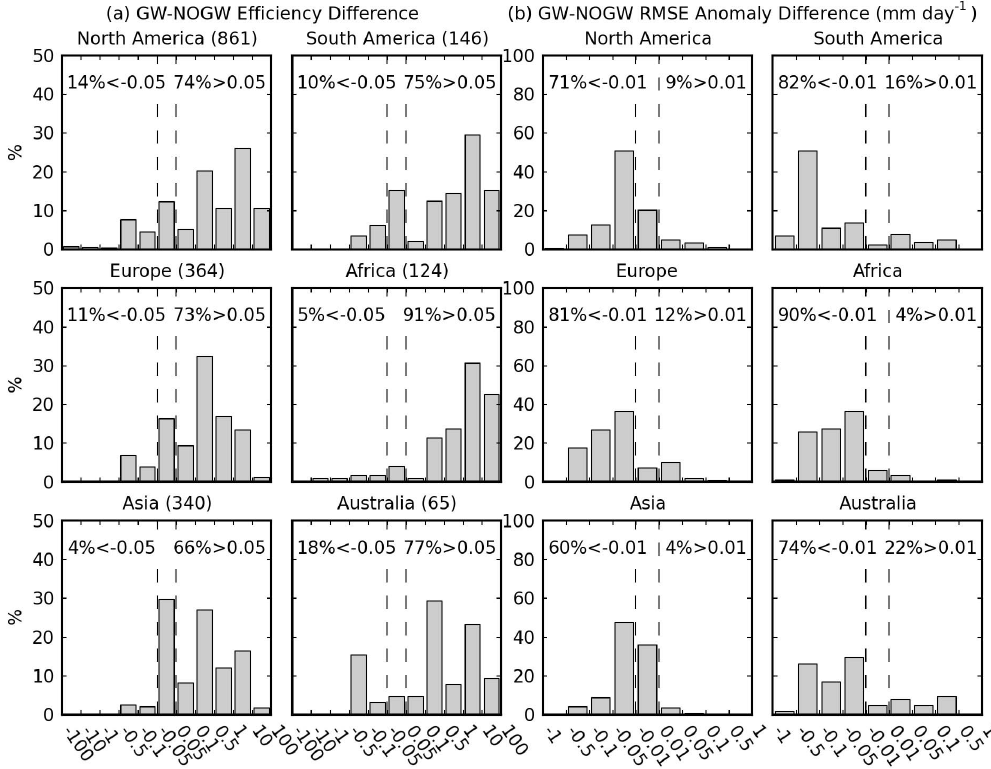
Fig. 4. Histogram of the differences between GW and NOGW in terms of (a) efficiency and (b) monthly anomaly RMSE for six continental regions. In the left six panels, the corresponding number of stations is added in brackets beside the name of each continental region. Table 2. Characteristics of the 12 largest river basins of the world shown in Figs. 5 and 8. The name, location, drainage area, coordinates, observation period and data source are